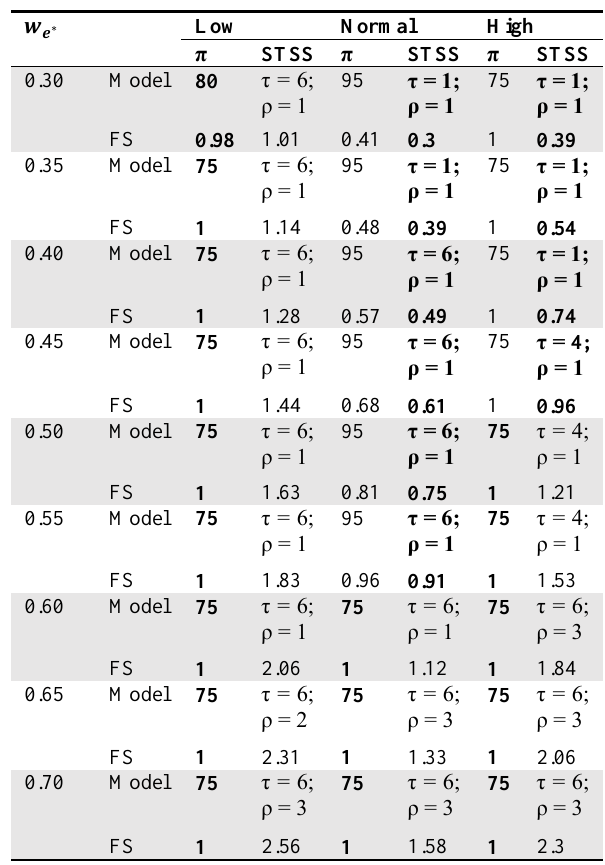
Table 2. The effect of the relative importance of FNR values on the best performing NRC models on different travel demand